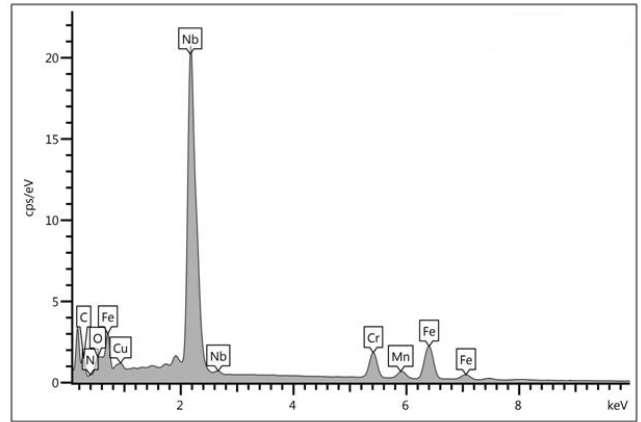
Figure 11. EDS X-ray spectrum of precipitate 1 from Figure 10.